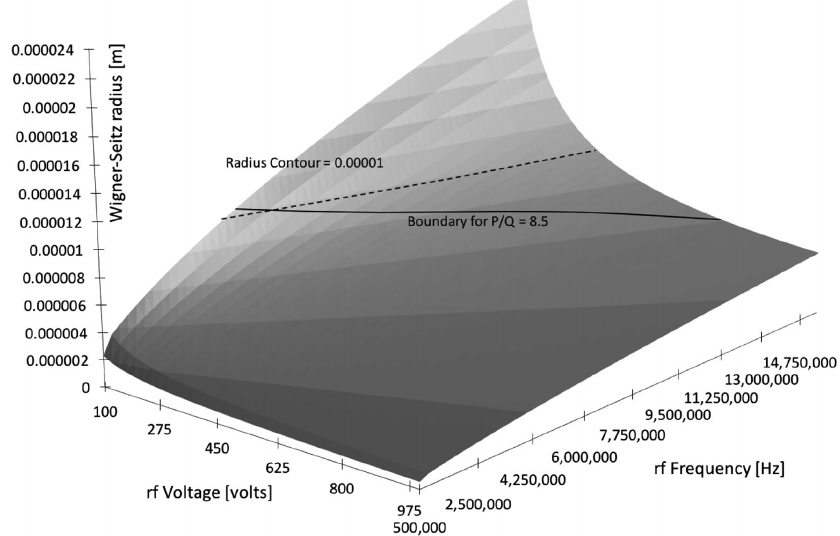
FIG. 2. The surface of values of Wigner-Seitz radii for a range of rf frequencies and voltage for 7 Li þ ions with v 0 ¼ 100 m = s.